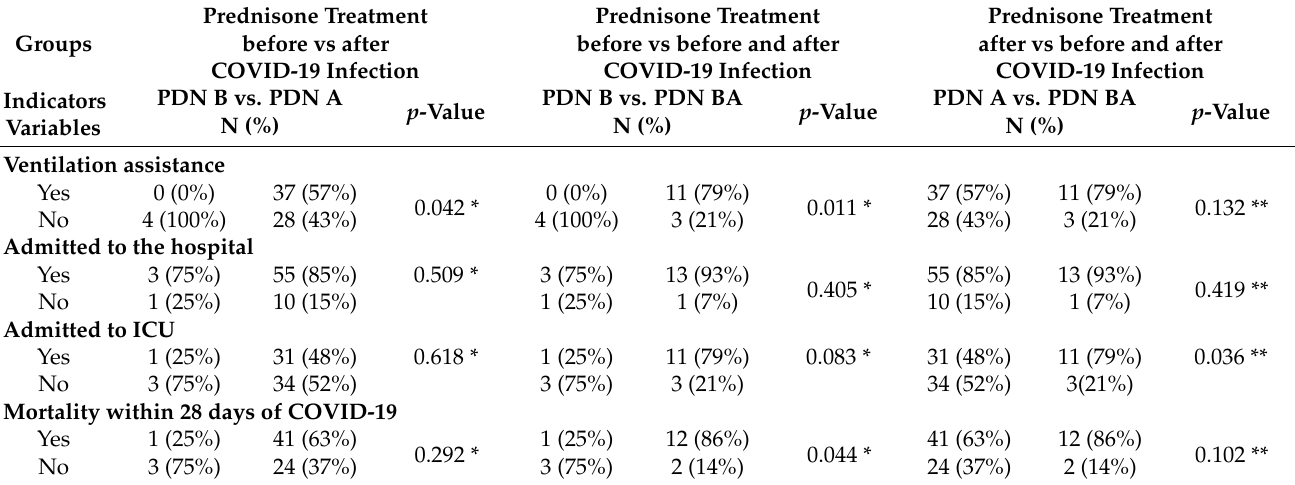
Table 6. Effect of prednisone treatment before, after, and before and after COVID-19 infection on disease